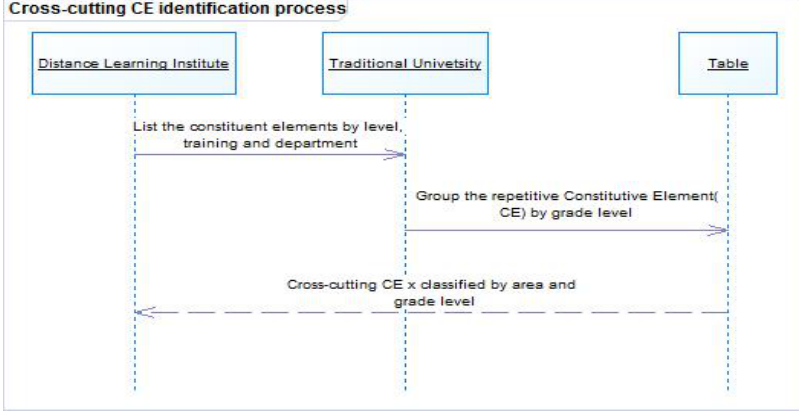
Fig. 1. Cross-cutting CE identification process